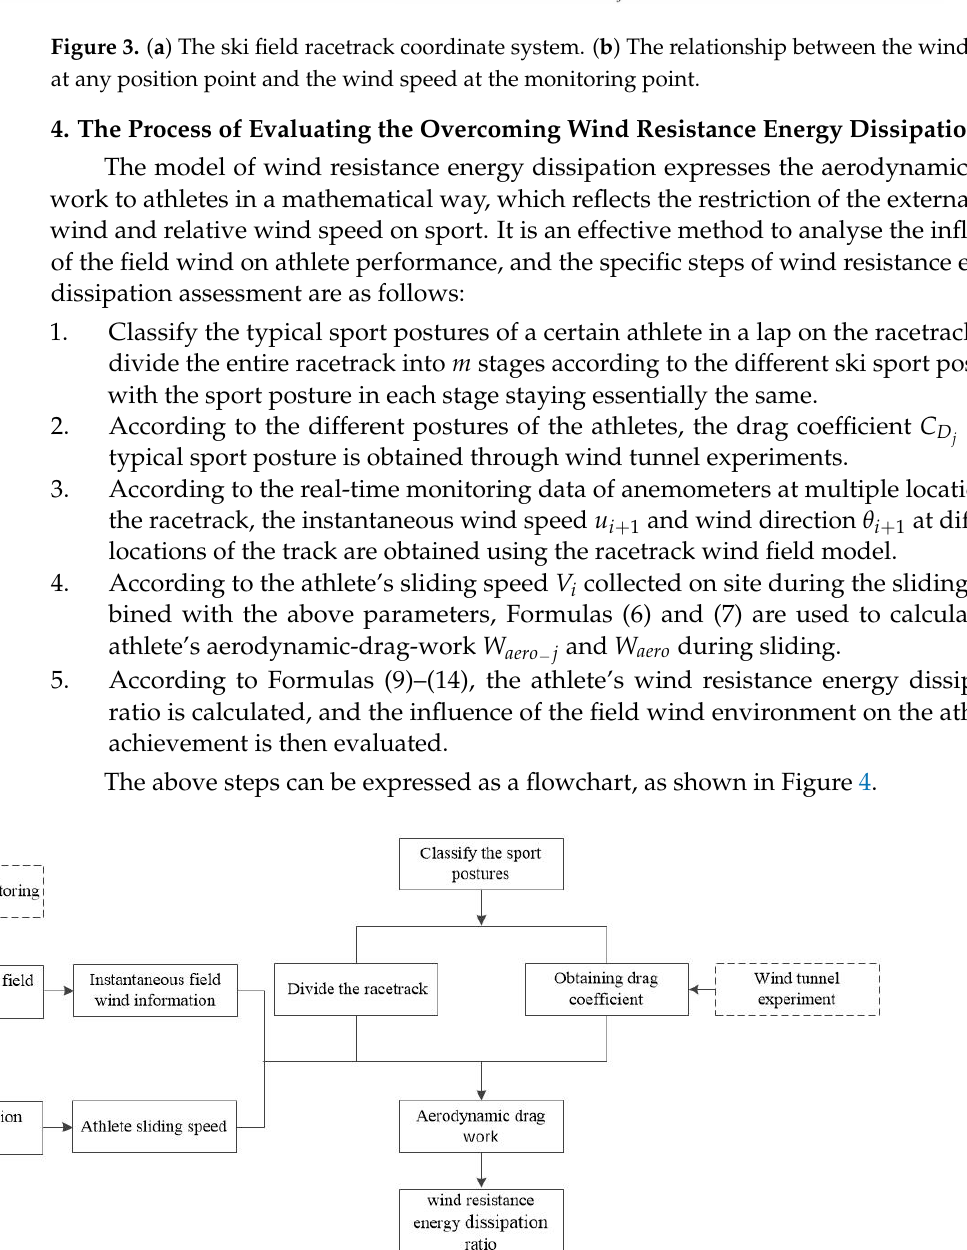
Figure 3. ( a ) The ski field racetrack coordinate system. ( b ) The relationship between the wind speed at any position point and the wind speed at the monitoring point.